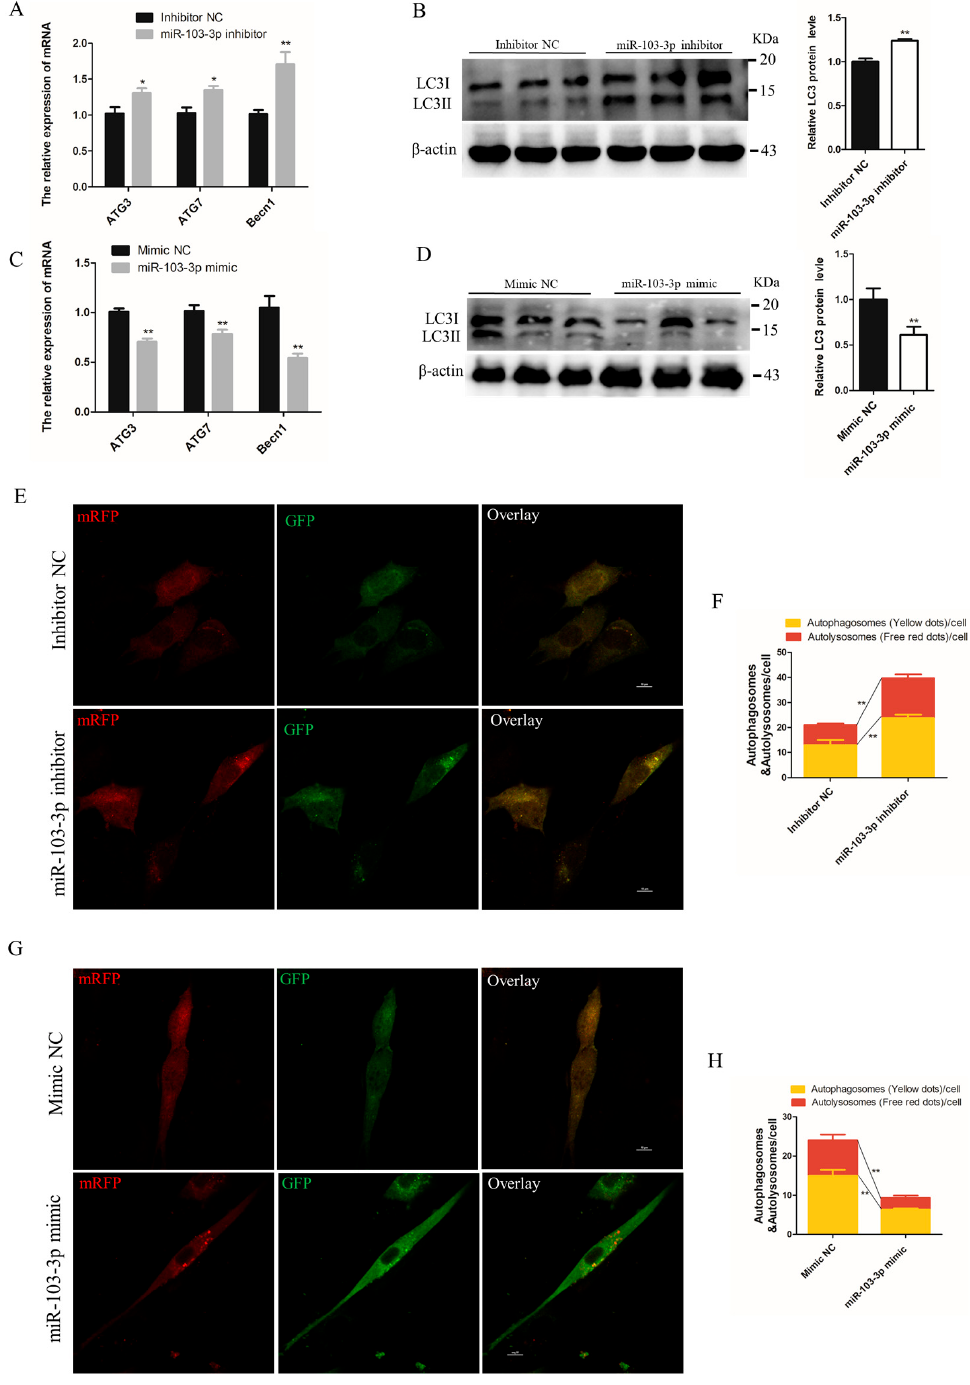
Figure 3. miR-103-3p inhibited autophagy of C2C12 cells. ( A , C ) The mRNA expression of ATG3 , ATG7 , and Becn1 in C2C12 cells was determined by qRT-PCR at 24 h after transfection with the miR-103-3p inhibitor or mimic. n = 3. ( B , D ) The protein expression of LC3 in C2C12 cells was determined by western blot at 48 h after transfection with the miR-103-3p inhibitor or mimic. β -Actin was used as the endogenous control. n = 3. ( E , G ) The autophagosomes and autolysosomes of C2C12 cells with miR-103-3p knockdown or overexpression were visualized by confocal microscopy at 24 h after treatment with the mRFP-GFP-LC3 adenovirus. Red fluorescence indicates autolysosomes; green fluorescence indicates lysosomes; yellow fluorescence indicates autophagosomes. Scale bar = 10 μ m. ( F , H ) Mean numbers of autophagosomes and autolysosomes in overlay images per cell. n = 3. * p < 0.05, ** p < 0.01.